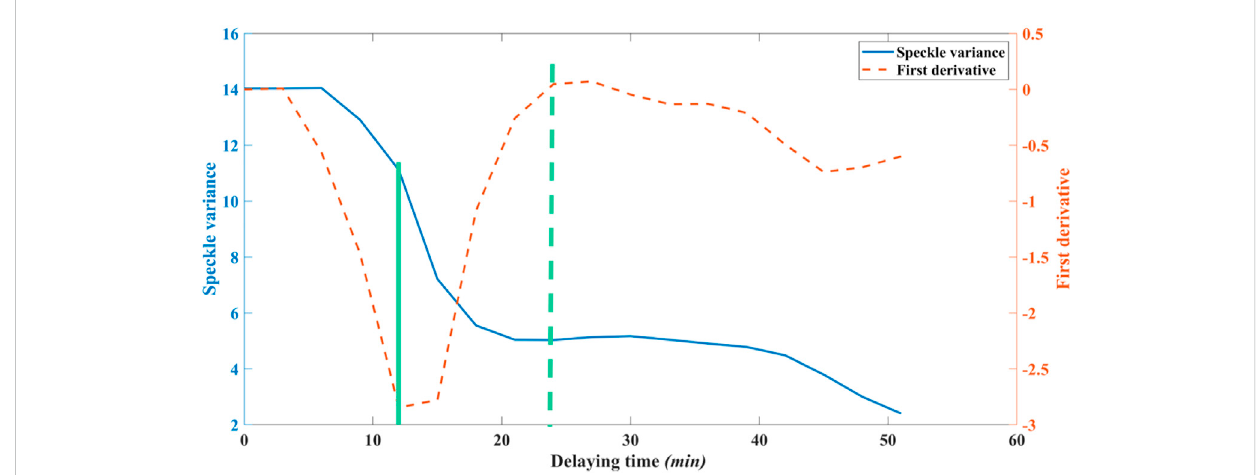
FIGURE 8 MedianspecklevarianceattherightedgeoftheOCTimageandits fi rstderivativeversusdelayingtime.Solidgreenlinerepresentsthevalley,anddot green line represents the peak of the fi rst derivative.